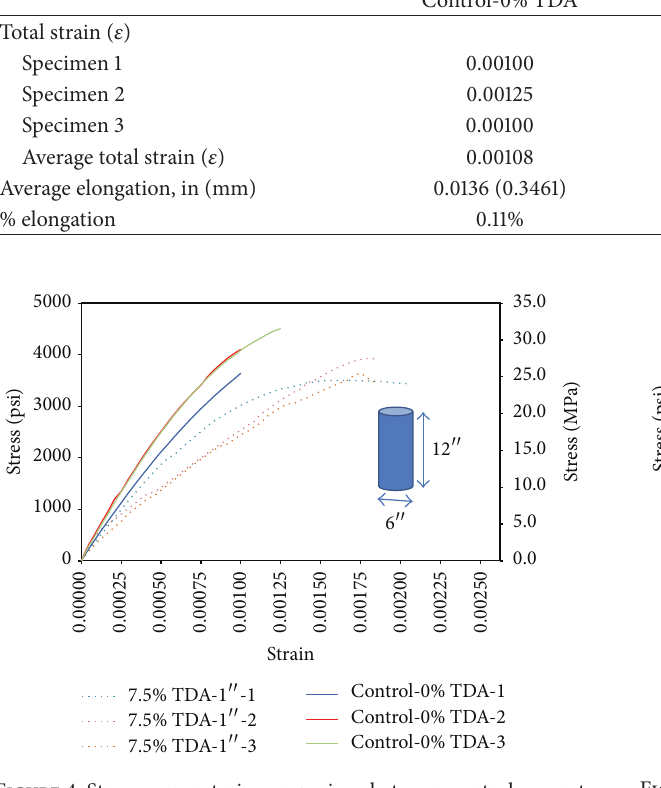
Figure 4: Stress versus strain comparison between control concrete and TDA concrete at 28 days.